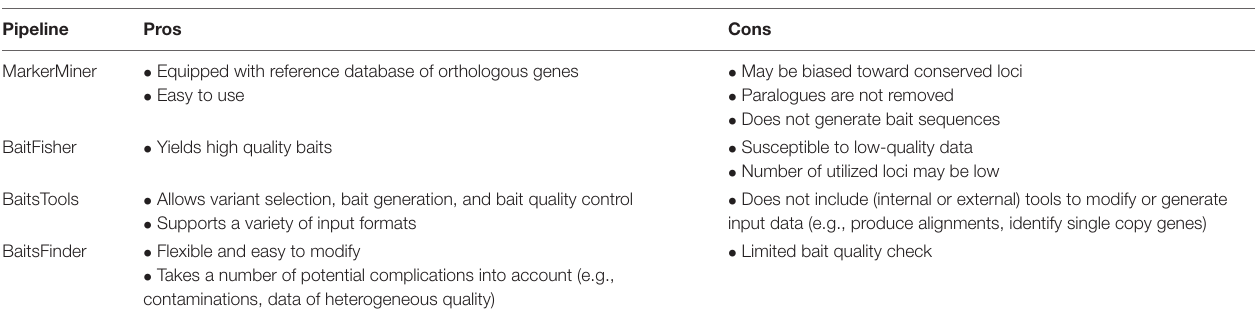
TABLE 3 | Comparison of major